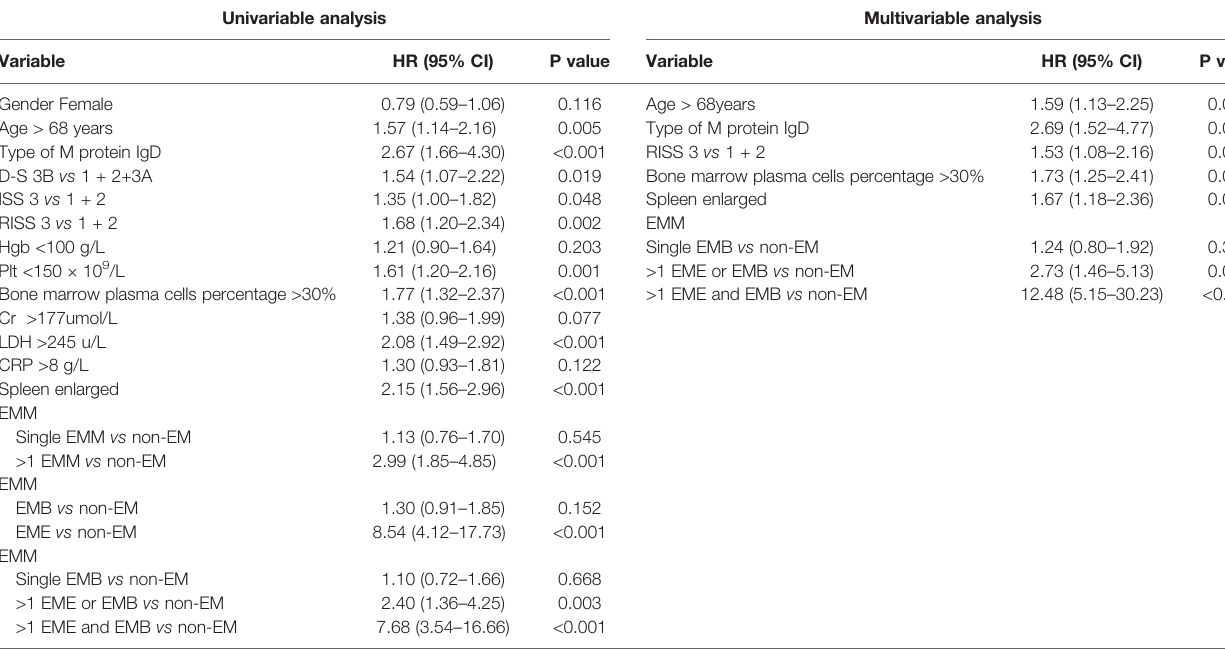
TABLE 3 | PFS of MM patients.